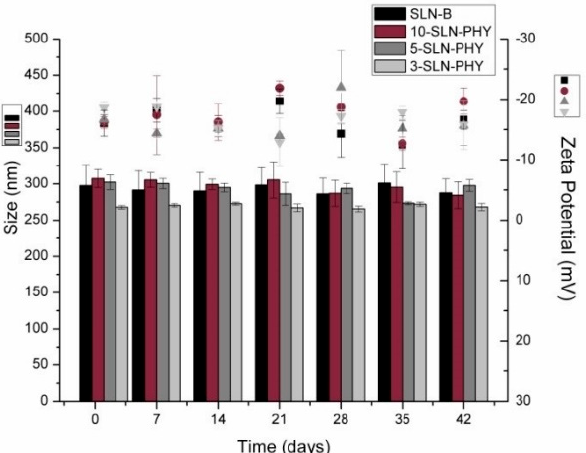
Figure 2. Mean diameter and zeta potential as a function of storage time for the solid lipid nanoparticles (SLN) and phytol-loaded solid lipid nanoparticles (SLN-PHY). Note: The data are expressed as mean ± standard deviation (SD) ( n = 3).